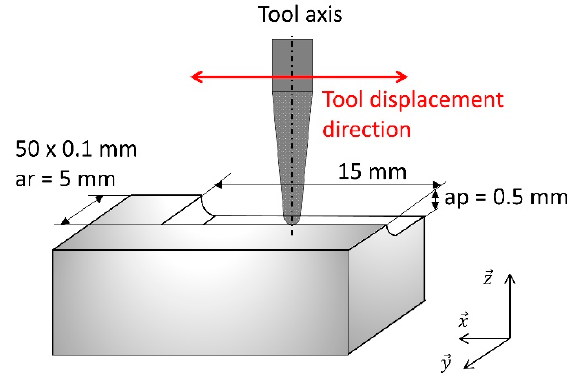
Figure 2. End milling mode mapping.